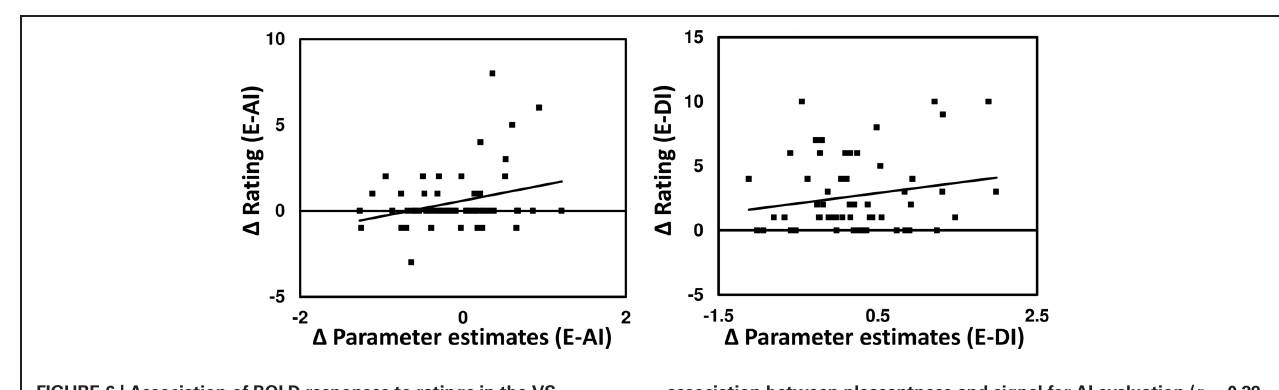
FIGURE 6 | Association of BOLD responses to ratings in the VS (averaged across all voxels of the functionally defined ROI) and subjective pleasentness ratings demonstrate a significant positive